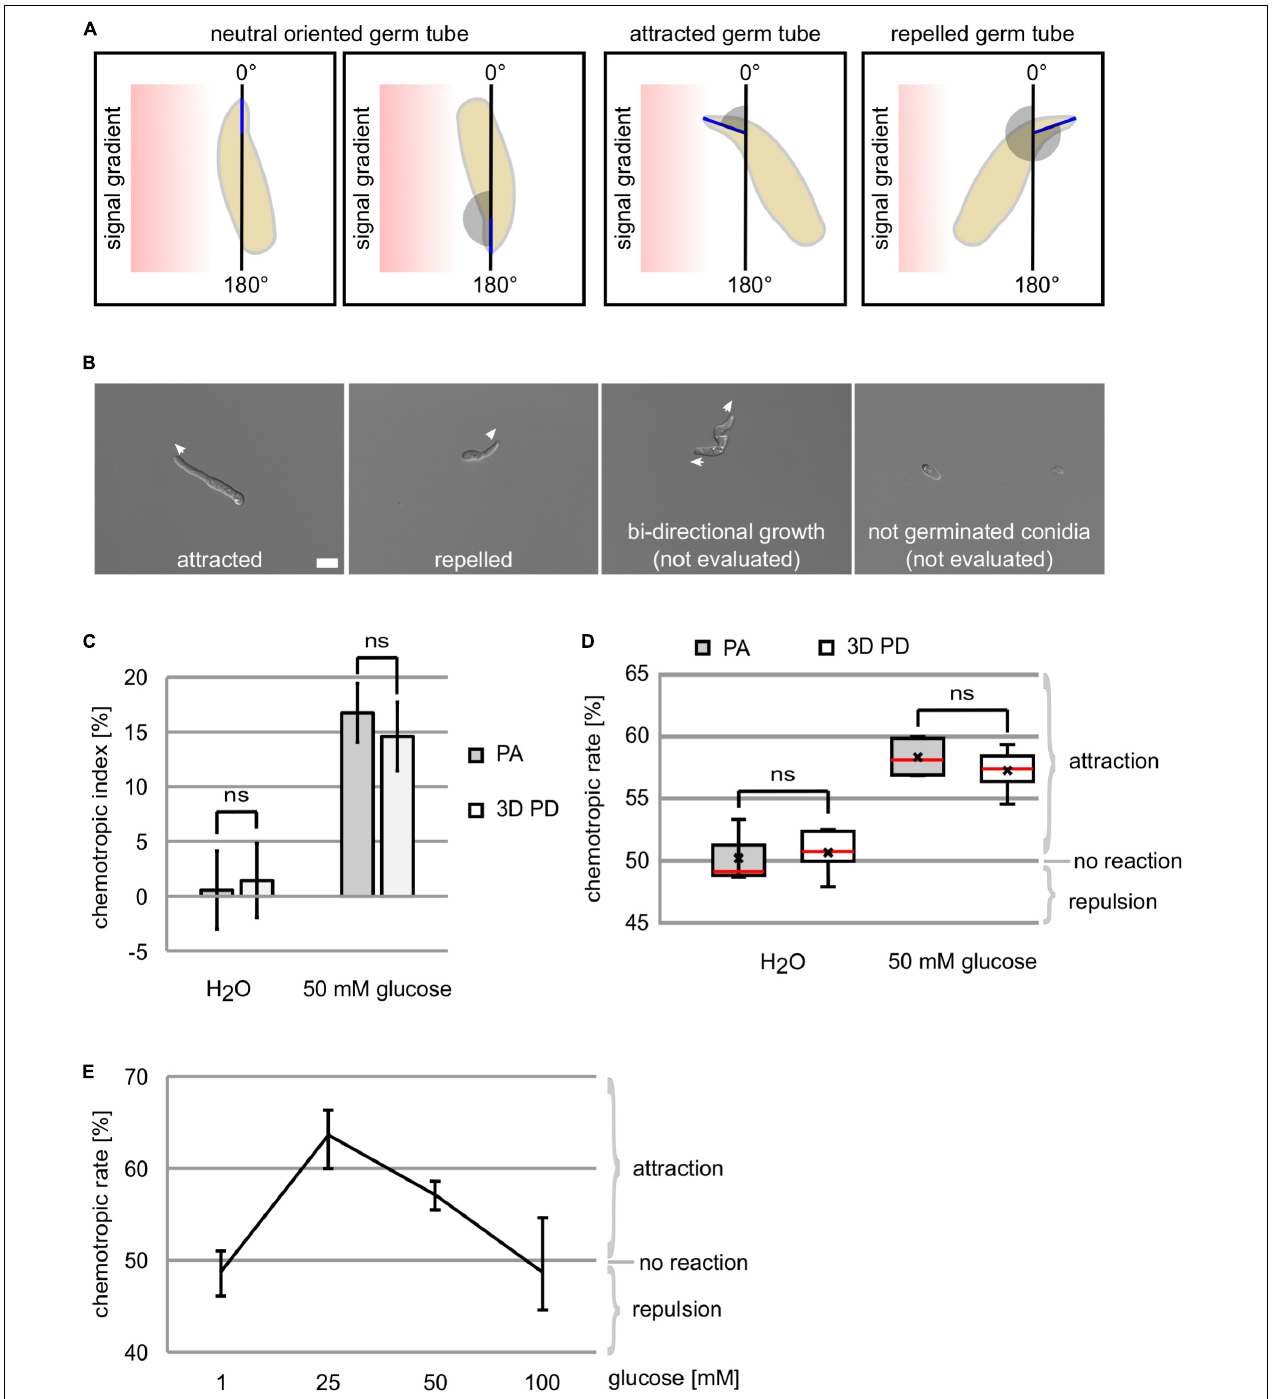
FIGURE 3 | Chemotropic growth of C. graminicola oval conidia. (A) Determination of the hyphal tip projection angle (blue) allows the evaluation of germ tube growth directions as attracted (1 ◦ –179 ◦ ), repelled (181 ◦ –359 ◦ ), or neutral (0 ◦ /360 ◦ and 180 ◦ ). (B) Evaluation of germ tube growth direction to a gradient of 50 mM glucose after incubation for 6 h, size bar = 10 µ m. (C–E) Growth re-direction of germlings derived from C. gramincola oval conidia to glucose gradients is quantified using the original plate assay (PA) and the new developed 3D printed device (3D PD) after 6h of incubation at 23 ◦ C, n ≥ 4, ns = not significant ( p > 0.05). (C) Depiction of results as deviation from the expected attraction potential of the negative control (water), termed chemotropic index. For each replicate, a minimum of 70 germlings were evaluated. (D) Data are provided as chemotropic rate, giving the ratio of attracted to total germlings. For each replicate, a minimum of 40 germlings were evaluated. Meridian is indicated in red, average by x. (E) Dose-response curve of germlings to glucose concentrations as indicated quantified using the 3D printed device. For each replicate, a minimum of 40 germlings were evaluated.